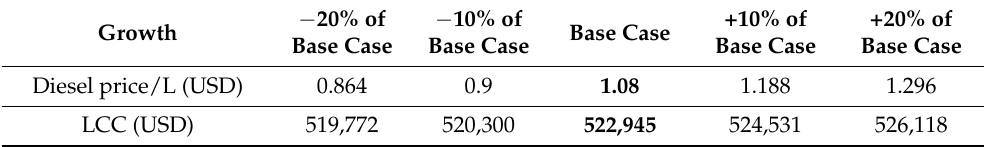
Table 16. Optimal configuration results with the variation of diesel